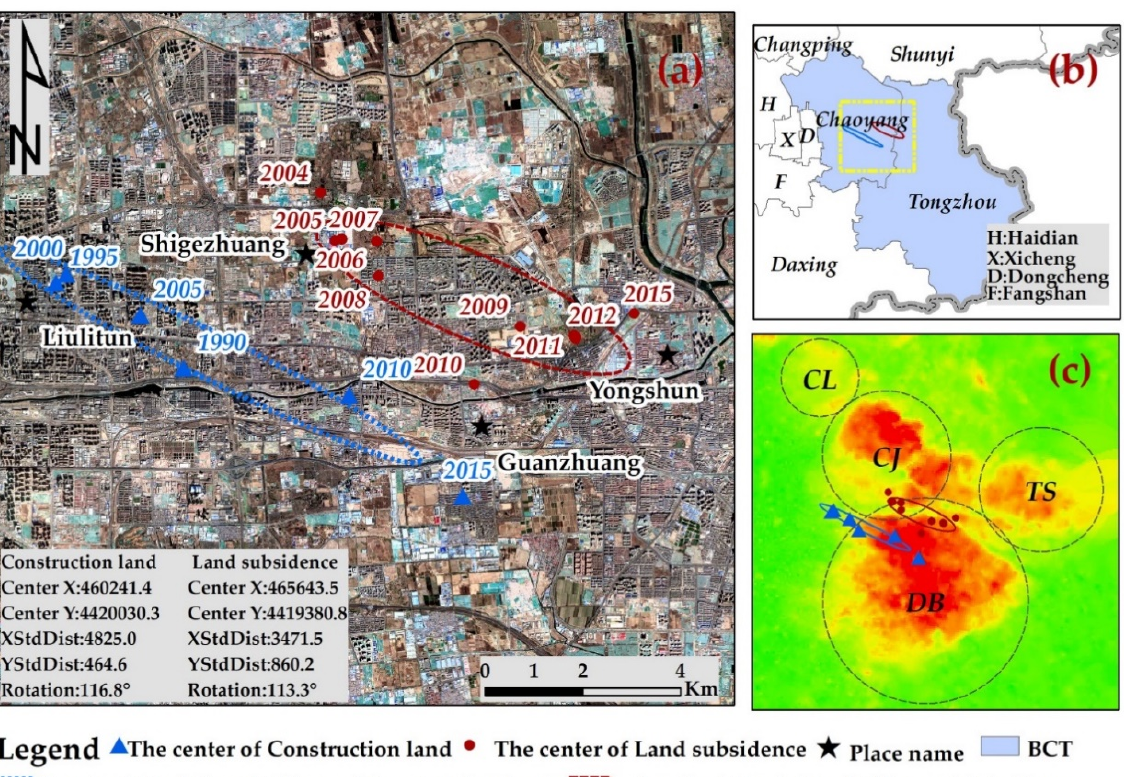
Figure 8. Response relationship between land subsidence and urban expansion. ( a ) shows the relationship between land subsidence and urban expansion. The red dot represents the center of Land subsidence, and the blue triangle represents the center of Construction land. ( b ) shows the location of the ( a ). ( c ) shows the relationship between land subsidence and urban expansion. The black circle represents the distribution of the subsidence funnel in the BCT area.